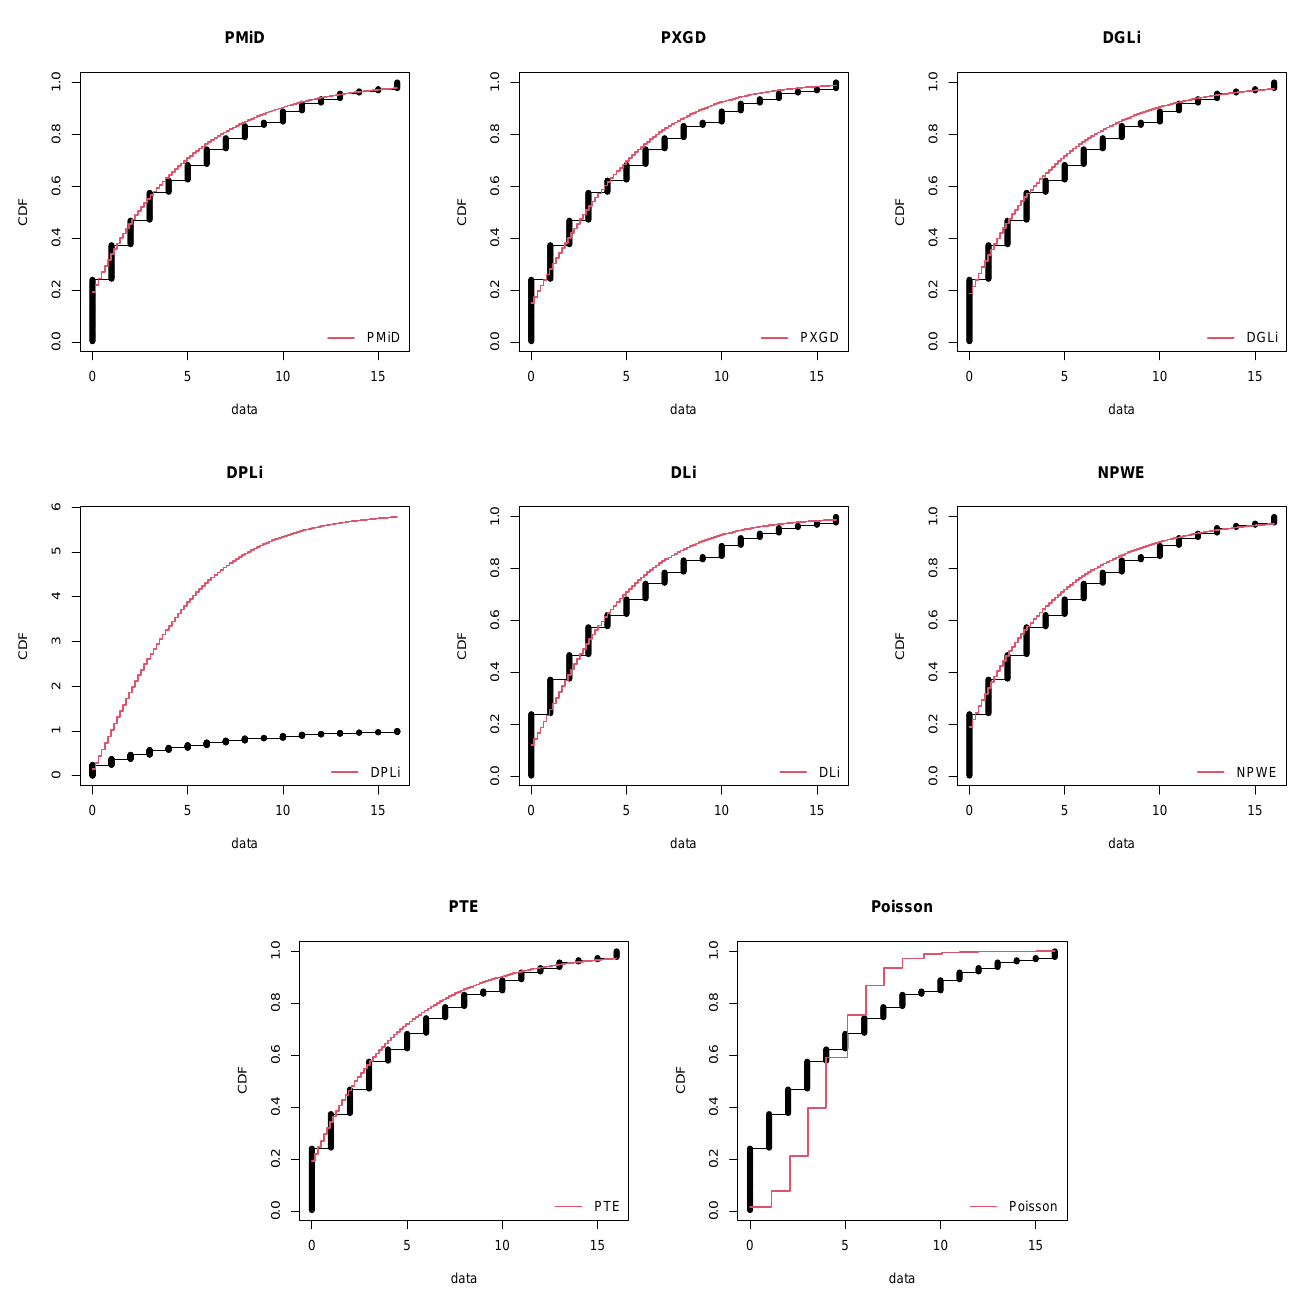
Figure 4. Empirical cdfs of the fitted distributions for the Armenia